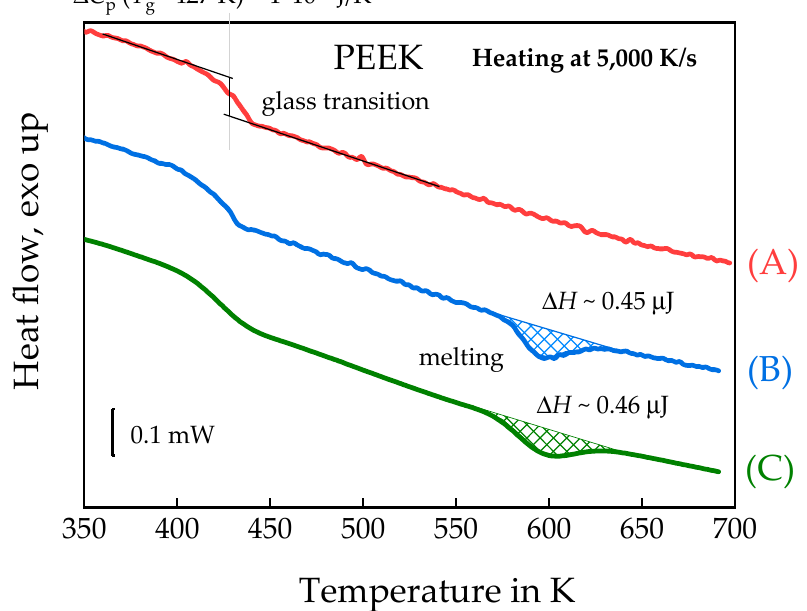
Figure 7. FSC heating curves of PEEK recorded using a rate of 5000 K / s. ( A )—after quenching the melt to 300 K, ( B )—after interrupted annealing at 564 K for a total time of 10 s and ( C )—after annealing at 564 K for 10 s without interruptions, according to the temperature–time program in Figures 4b and 4a, respectively.